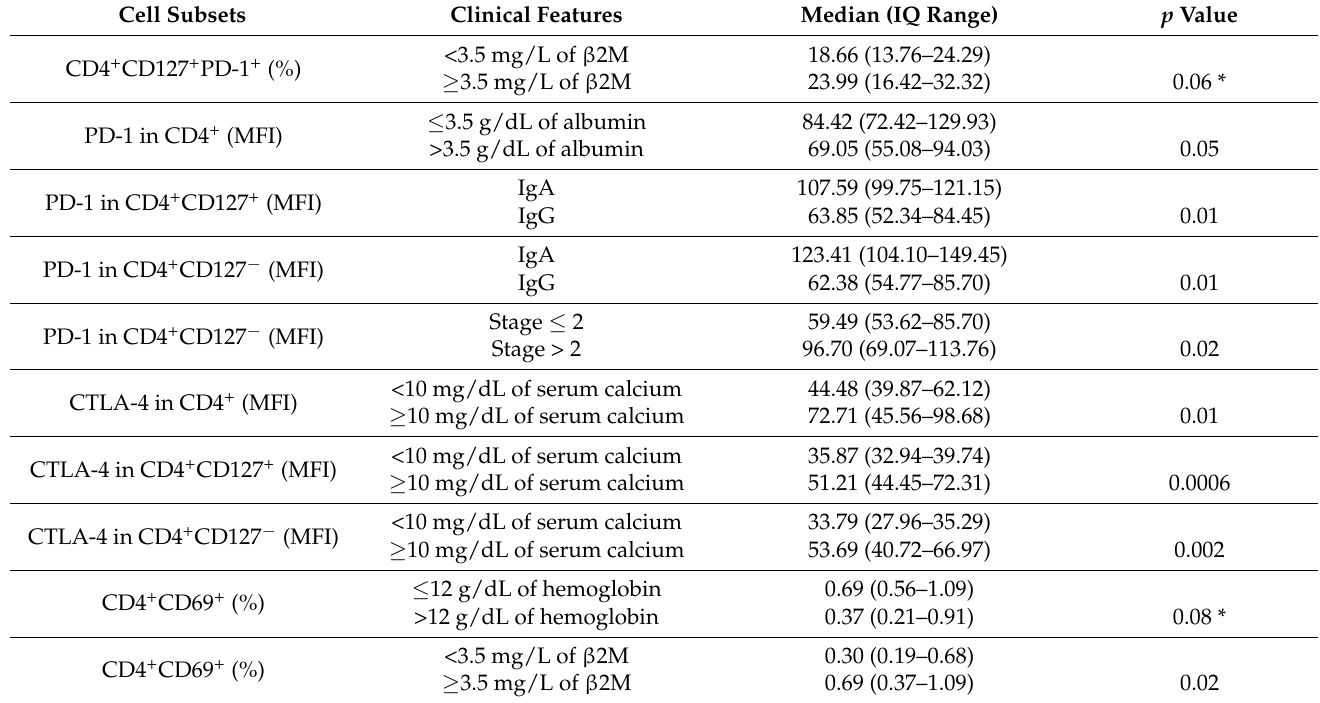
Table 4. Association of immune features with clinical characteristics of multiple